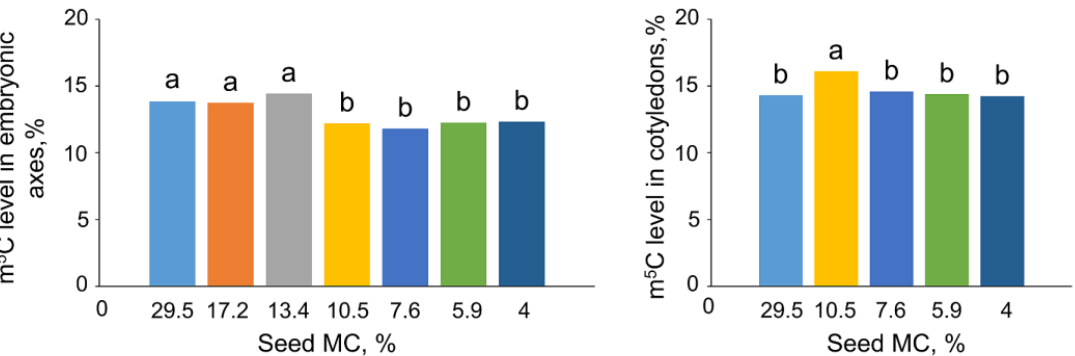
Figure 2. Effect of seed moisture content (MC) on the global DNA methylation of Fagus sylvatica L. embryonic axes and cotyledons. Values labeled with different letters are significantly different at p ≤ 0.05 , ANOVA, Tukey test. Data represent the mean ± se ( n = 5). Statistical analyses revealed a positive correlation between germination or seedling emergence and global m 5 C levels in embryonic axes. However, no such correlations were detected when m 5 C amount in cotyledons were taken into consideration (Figures 3 and 4). No relations between DNA methylation level changes in embryonic axes and cotyledons were noticed.